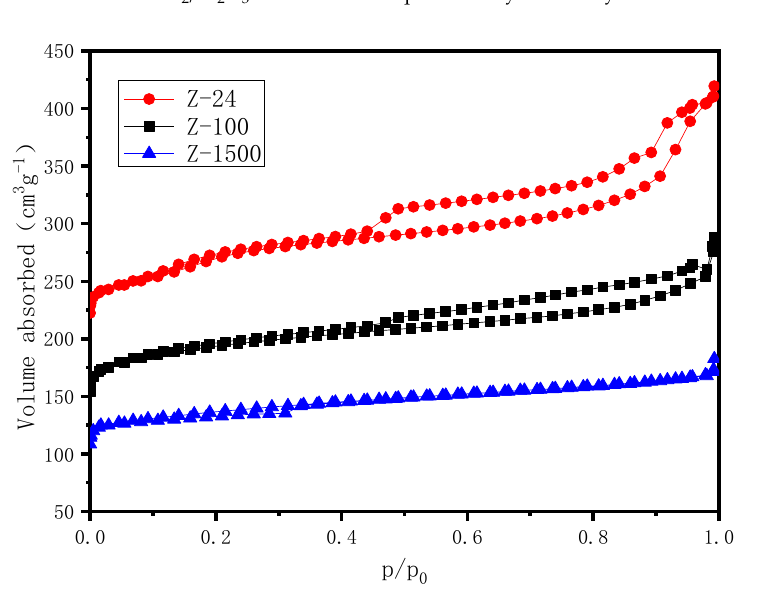
Figure 4. The N 2 sorption isotherms of zeolites with different molar ratios of Si/Al.